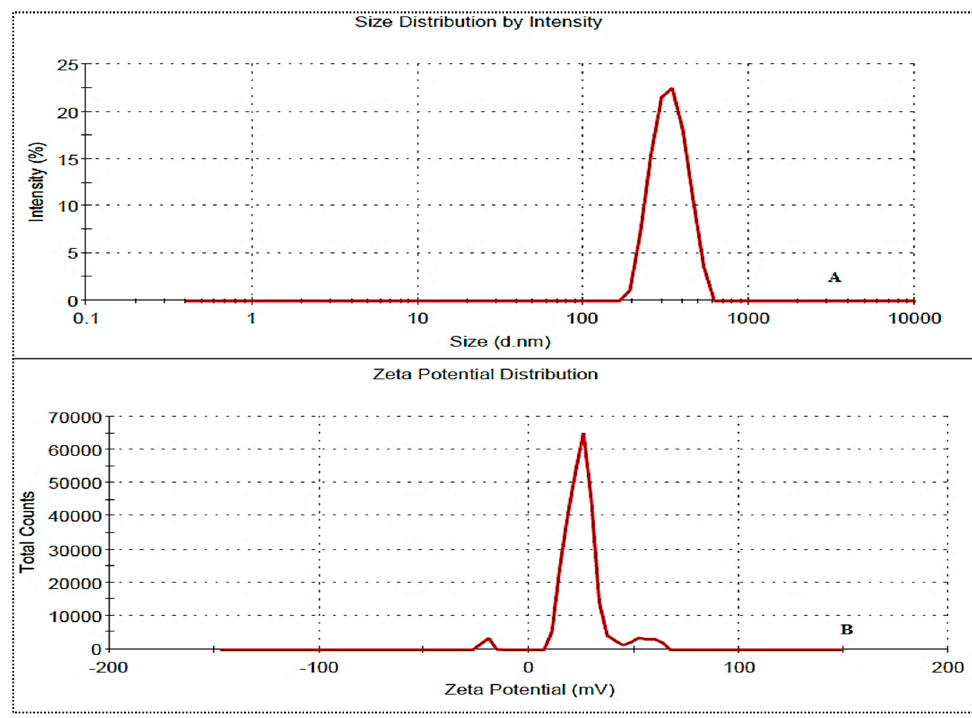
Figure 4. Particle size ( A ) and Zeta potential ( B ) of NG-HNop.